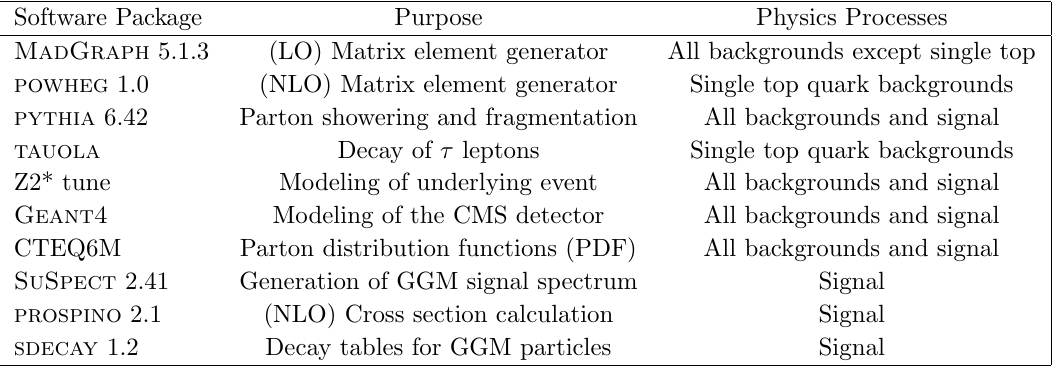
Table 1 . Software used in MC simulations of